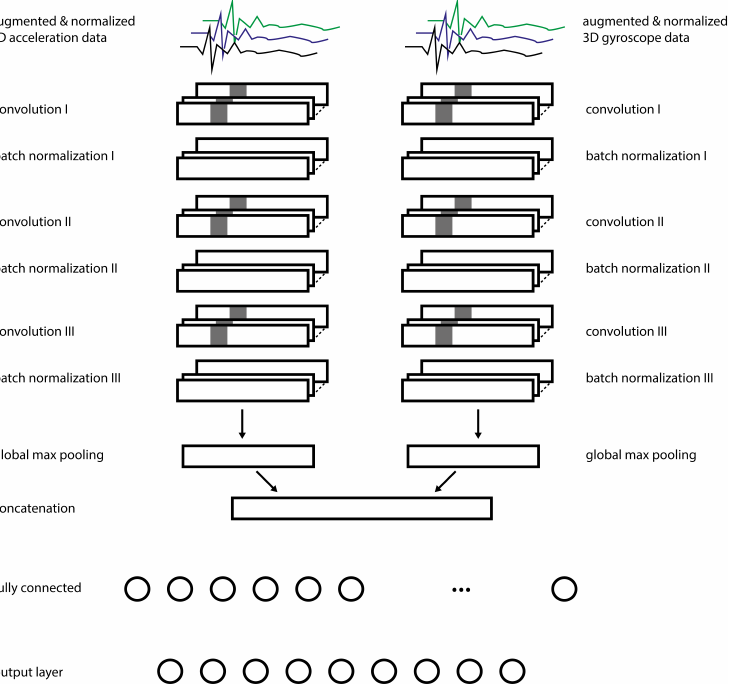
Figure 4. The architecture of the convolutional neural network, which was used in this work. The output dimensions of the layers are given at the top right of each row. The connections of the last two fully connected layers were omitted for better readability. The architecture was partly adapted from Fawaz et al.